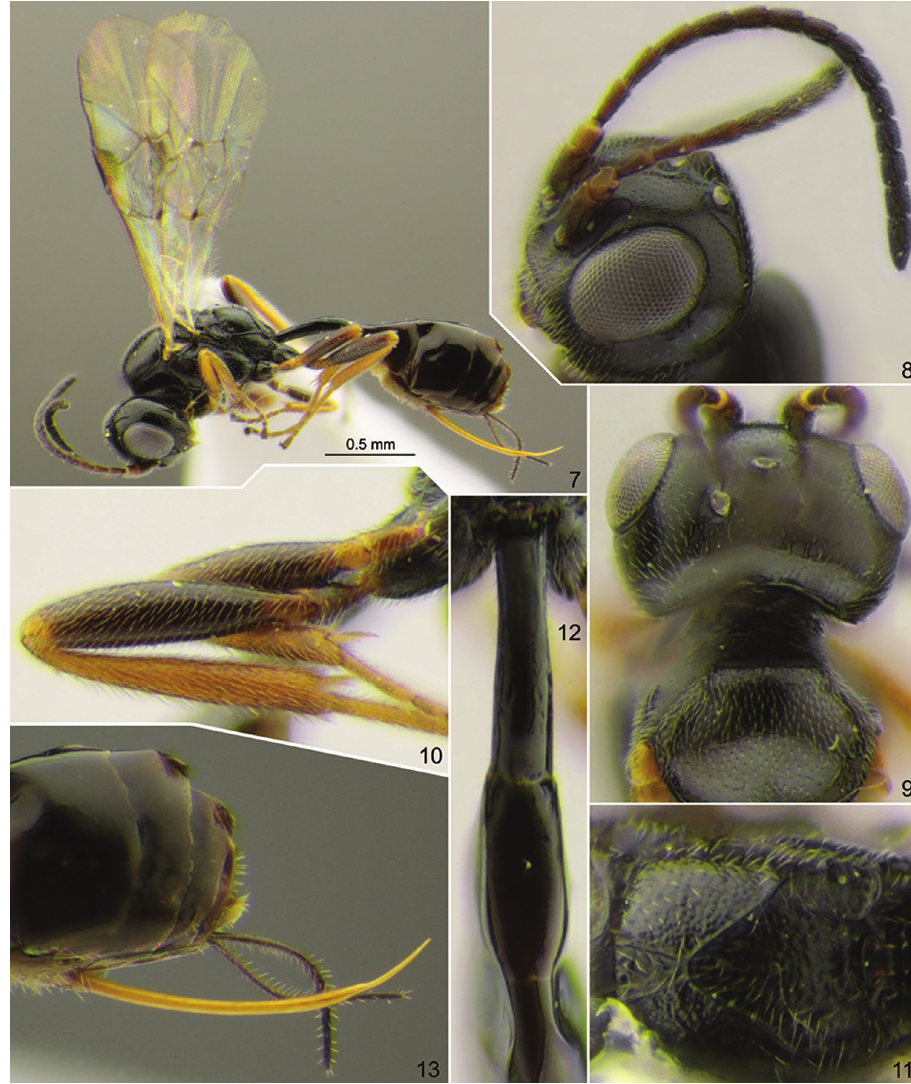
Figures 7–13. Phradis bufalosus sp. n., holotype female. 7 habitus, lateral view 8 head with antenna, lateral view 9 head and mesoscutum, lateral view 10 hind legs, lateral view 11 propodeum, dorsal view 12 base of metasoma, dorsal view 13 apex of metasoma with ovipositor, lateral view.